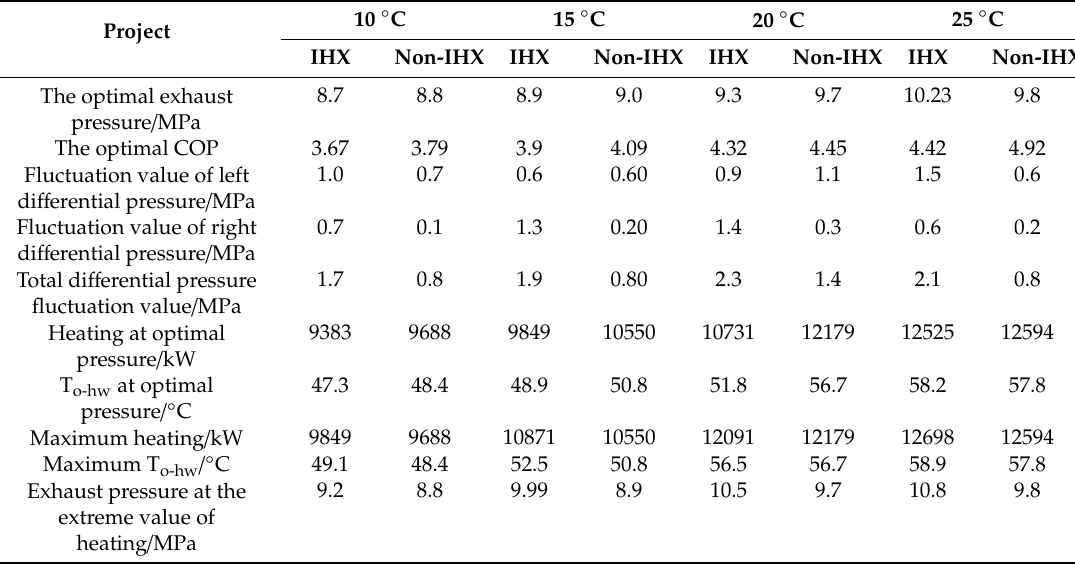
Table 6. Comparison of main performance parameters of HPWH system with and without IHX at di ff erent hot water inlet